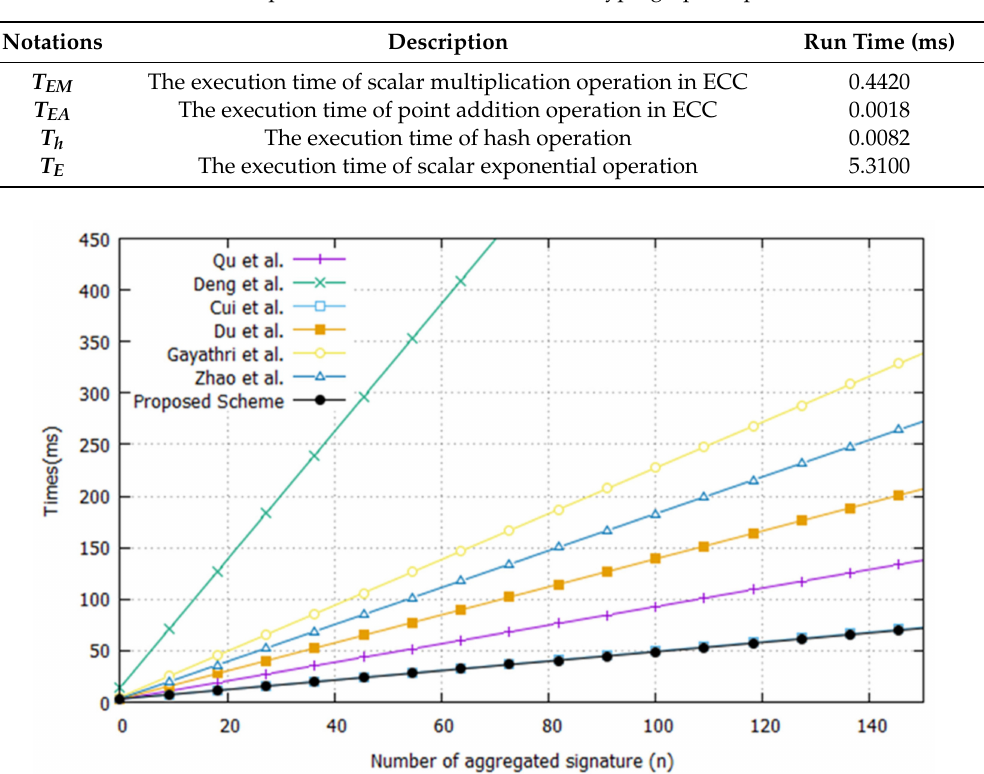
Table 2. Comparison of execution times with cryptographic operation.